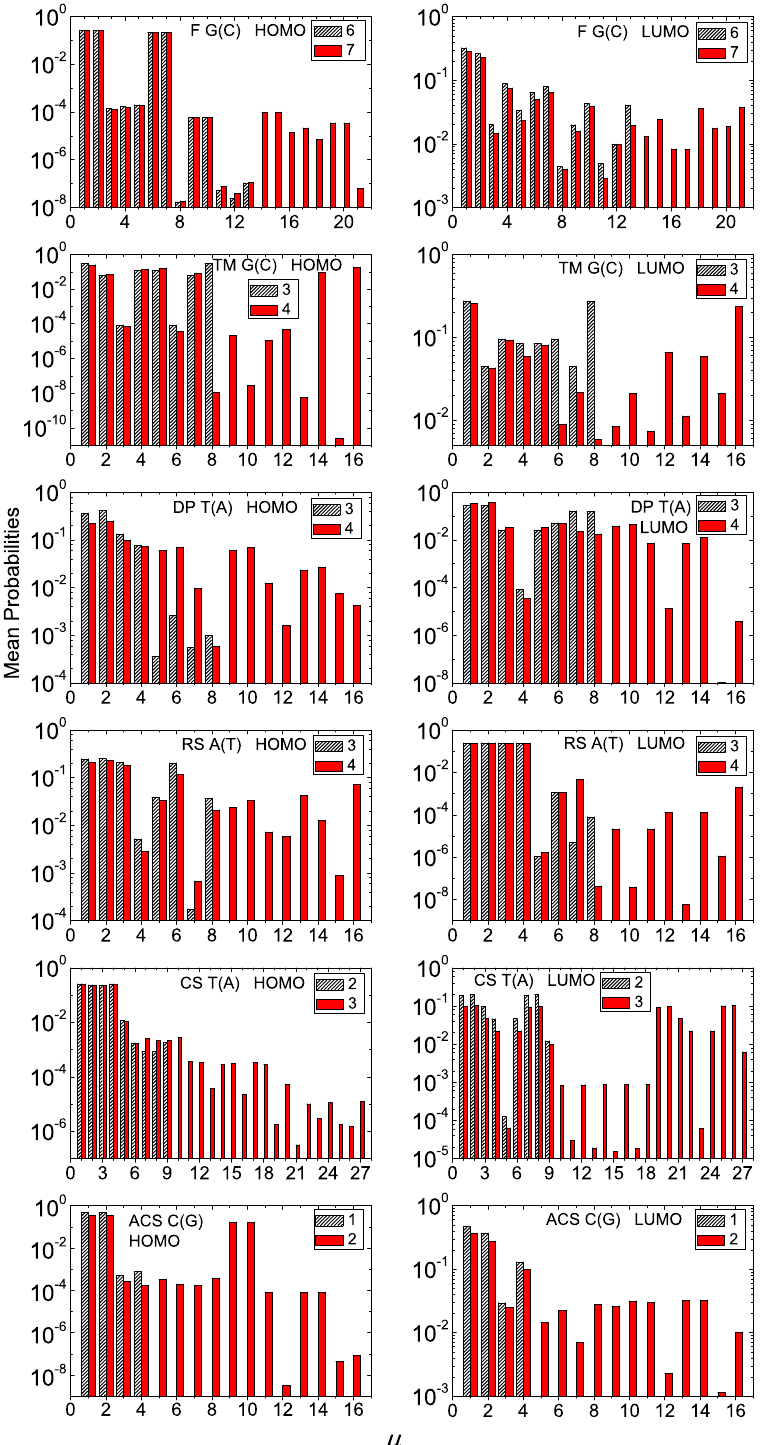
Figure 6. Mean over time probabilities to find the extra carrier at each monomer µ = 1, . . . , N , having placed it initially at the first monomer, for two consecutive generations (the number of which is denoted at each panel’s legend) for G(C), TM G(C), DP T(A), RS A(T), CS T(A), ACS C(G) polymers, for HOMO (left column) and LUMO (right column). The notation of polymers is given in Table